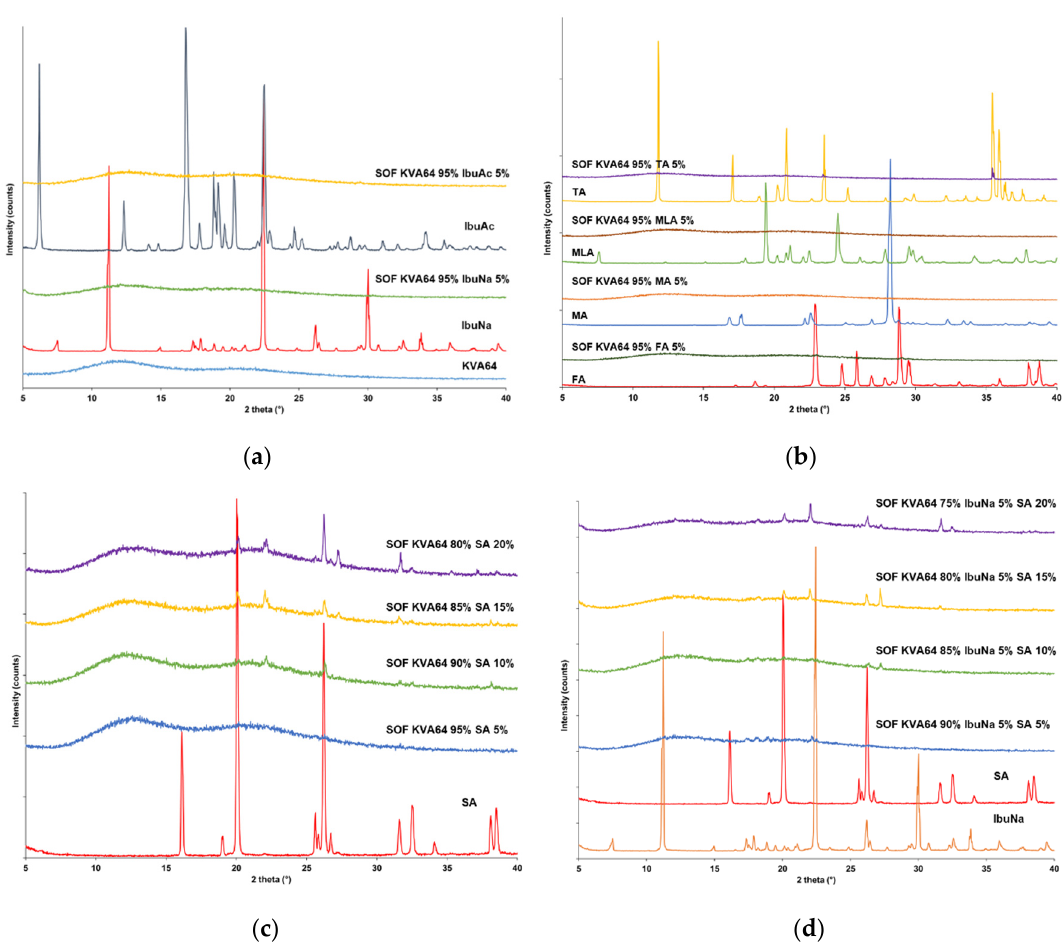
Figure 7. XRPD patterns: ( a ) KVA64, IbuNa, IbuAc and their sintered SOFs, ( b ) FA, MA, MLA, TA and their sintered SOFs, ( c ) SA and its sintered SOFs, ( d ) IbuNa, SA and their sintered SOFs.